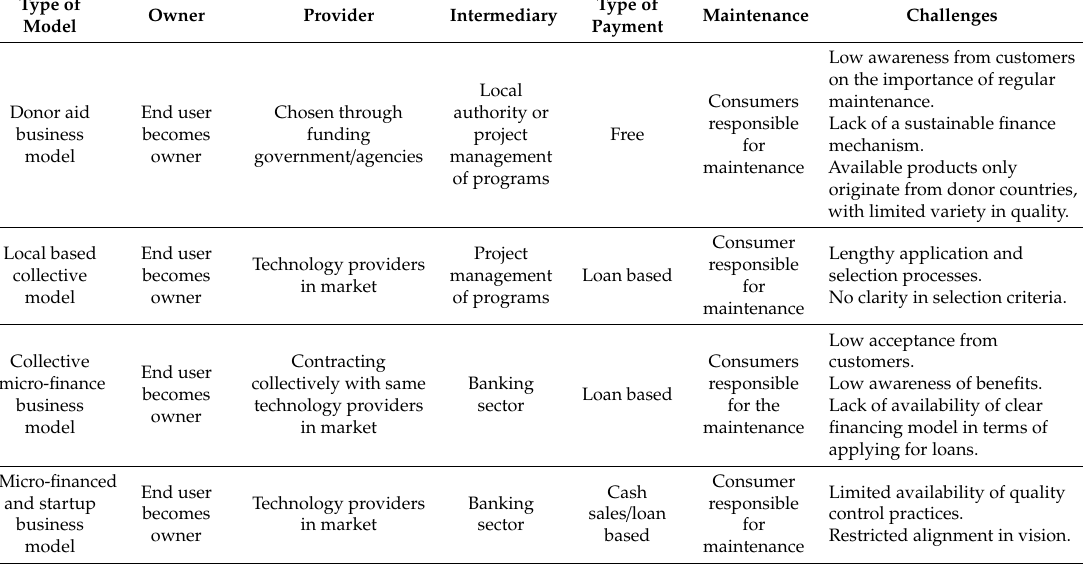
Table 1. Overview of financial models applied in Lebanon regarding solar energy